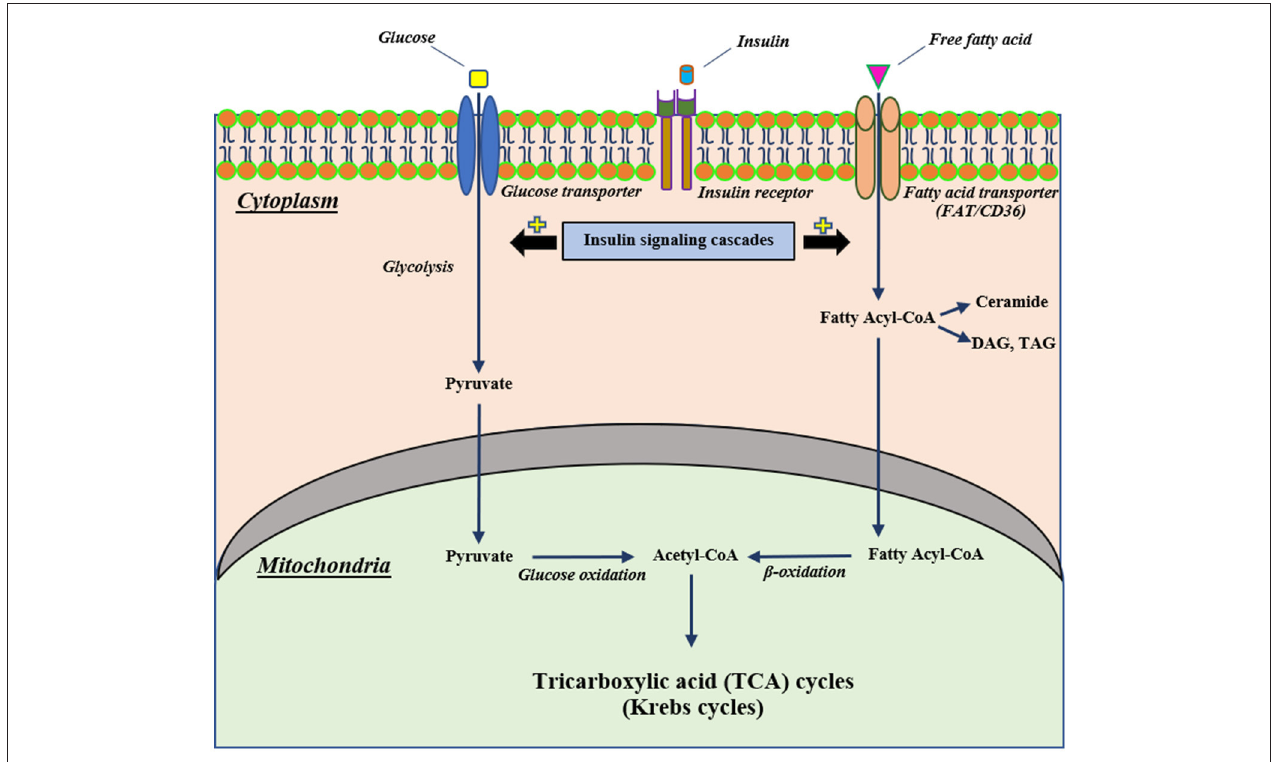
FIGURE 1 | The proposed mechanism of cellular insulin signaling on glucose and fatty acid metabolisms. Extracellular insulin can bind with its receptor, resulting in stimulating insulin signaling cascades. Stimulation of insulin signaling cascades can activate cellular glucose uptake through glucose transporters that intracellular glucose further can be converted to pyruvate by glycolysis and subsequently pass into the mitochondria to change to be Acetyl-CoA for the Krebs cycle. In addition to glucose metabolism, an activation of an insulin signaling cascade can also induce intracellular uptake of free fatty acid via a fatty acid transporter (FAT/CD36) and this free fatty acid can convert to fatty acyl-CoA that translocates to mitochondria and changes to Acetyl-CoA as well as glucose metabolism. CD36, cluster of differentiation-36; DAG, diacylglycerol; FAT, fatty acid translocase; TAG,